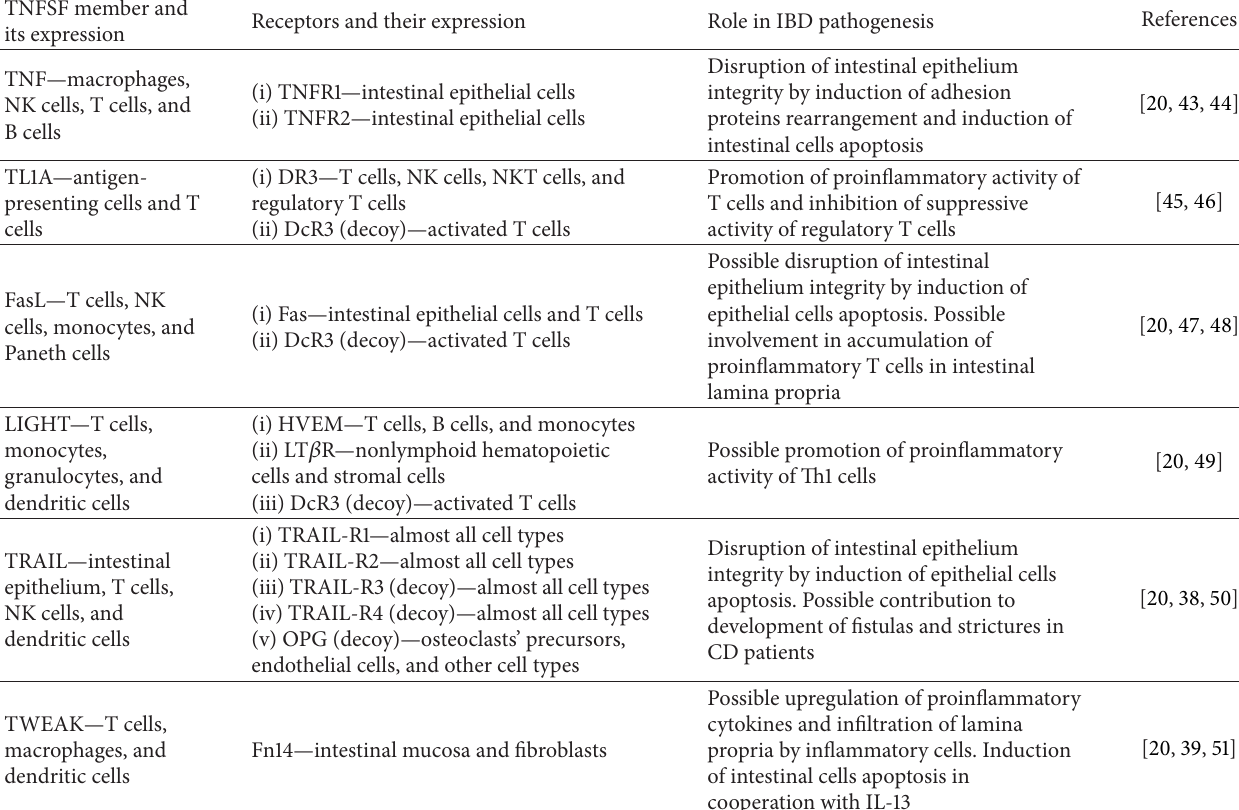
Table 1: Overview of the expression and function of the major members of TNSF superfamily in